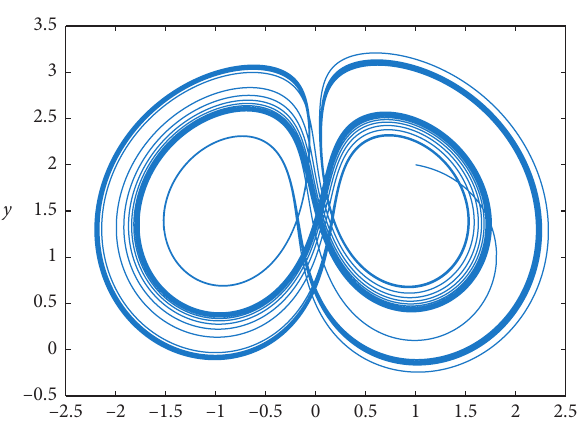
Figure 6: Dynamic behavior of fractional financial chaotic model with α � 0 .